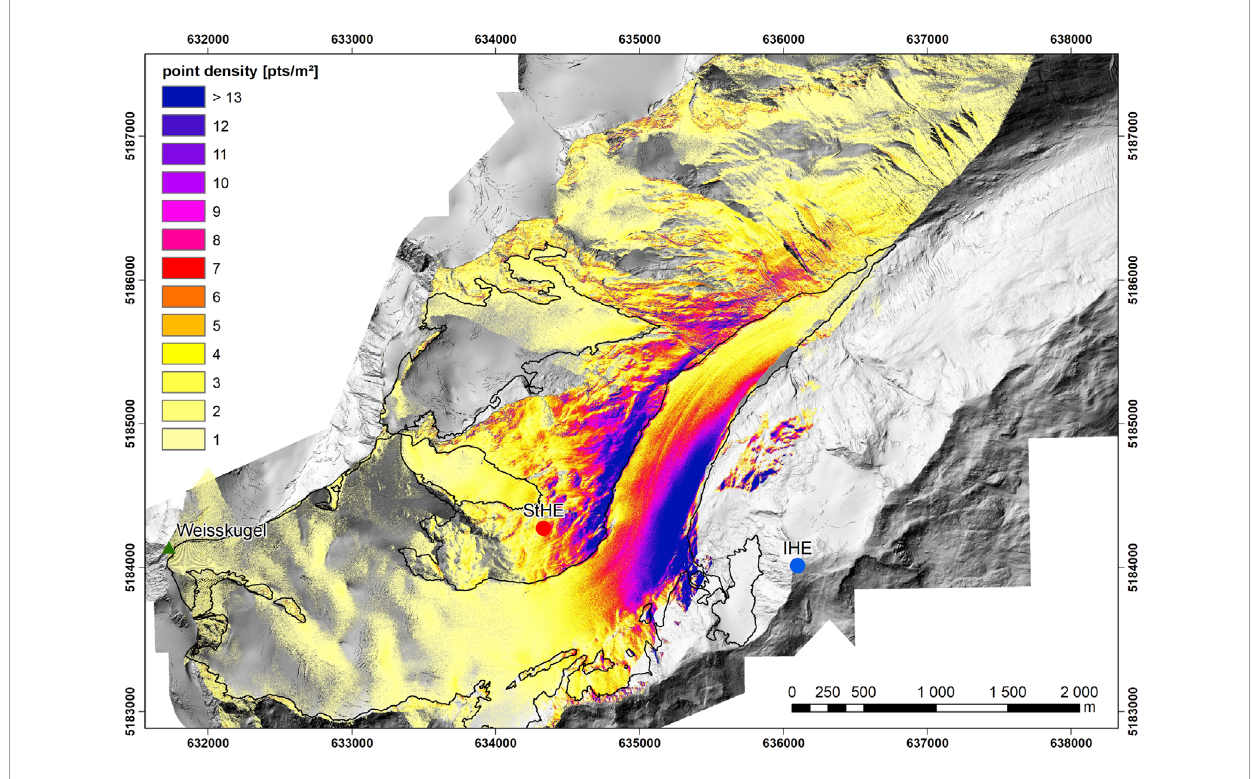
FIGURE 10 Point density in points m −2 from IHE. The dark purple areas have point densities > 13 points m −2 .